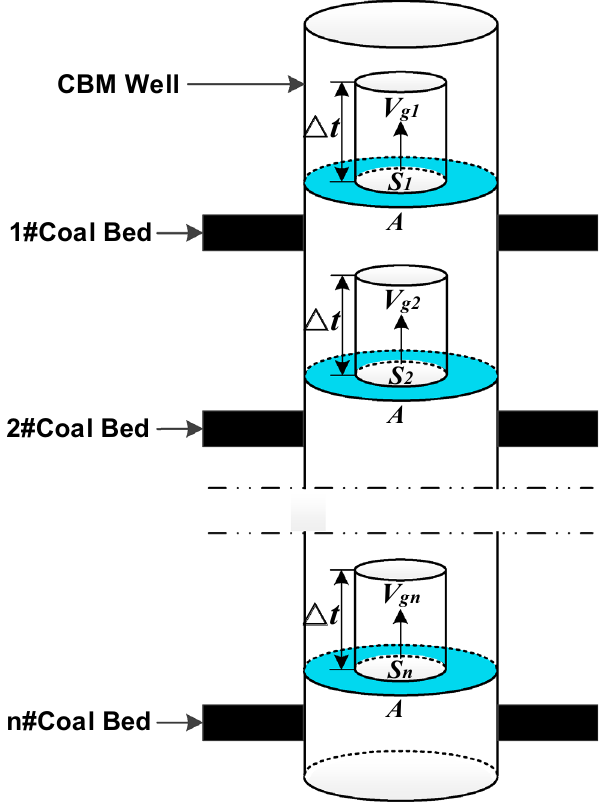
Fig. 1 Method used for calculating gas output from a single wellbore containing multiple coal